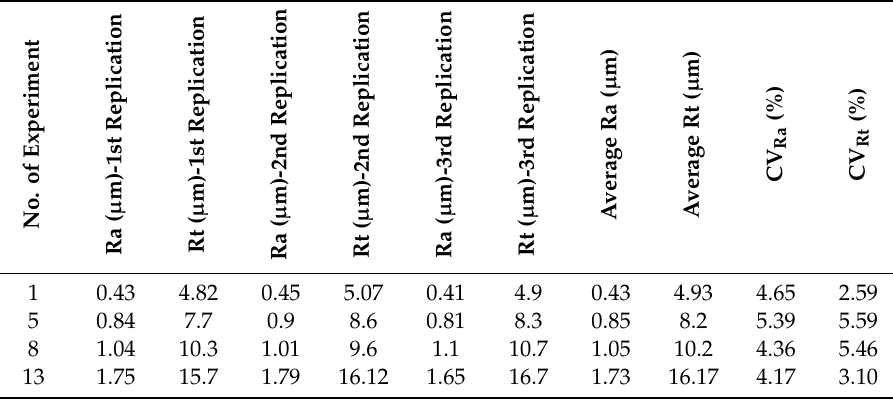
Table 5. Preliminary tests results regarding surface roughness